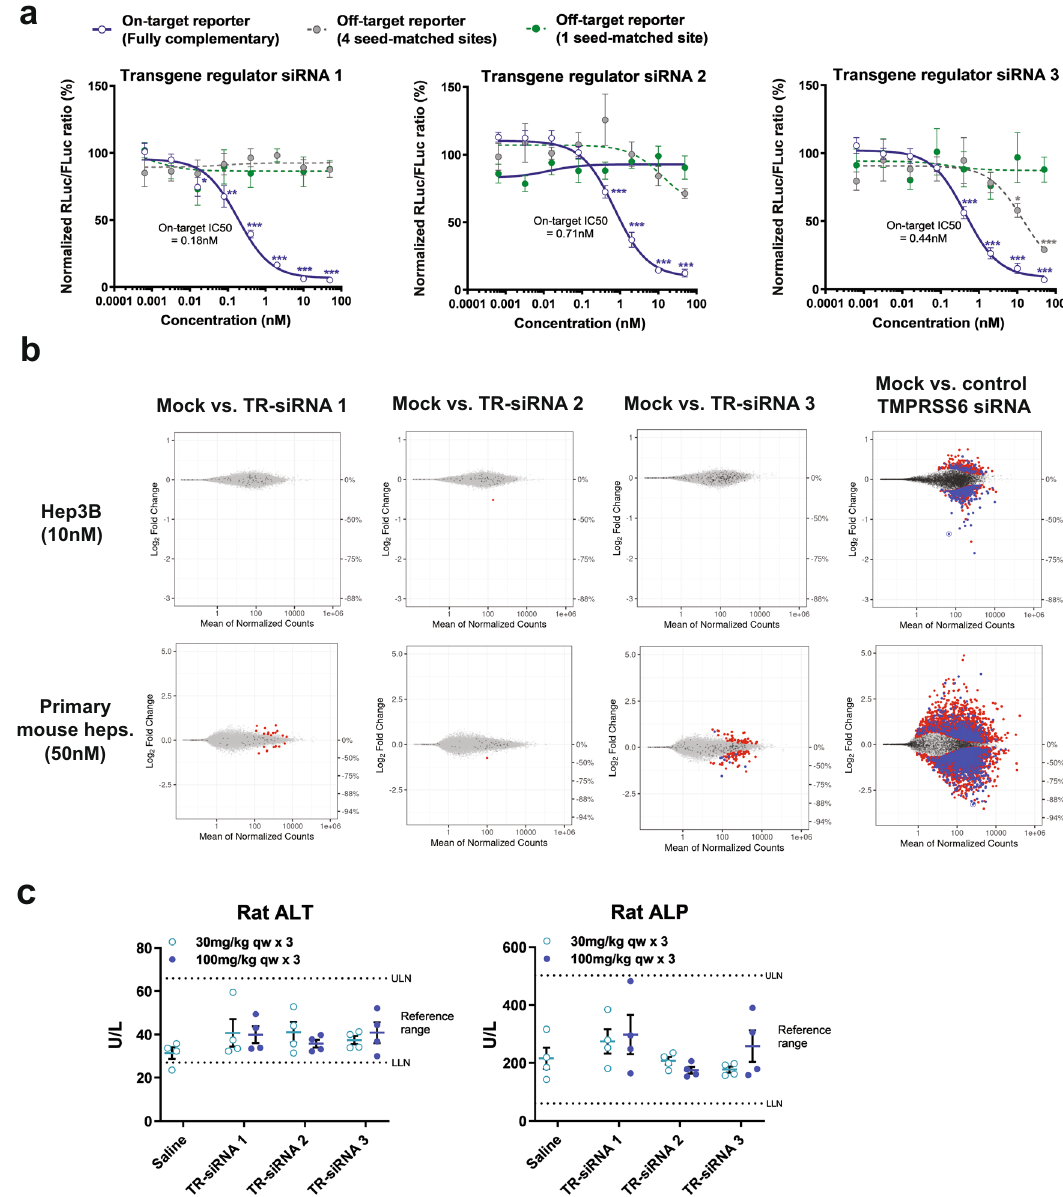
Fig. 4 | In vitro characterization of on- and off-target activity of transgene regulatorsiRNAsequences.a On-targetsilencingef fi cacy(solidblueline)ofthree leadtransgeneregulatorsiRNA(TR-siRNA)sequencesasassayedbyco-transfection ofseriallytitrateddosesofsiRNAwithdualluciferasesensorscontainingaperfectly matched binding site in the 3 ’ UTR of Renilla luciferase (RLuc). Seed-mediated off- target repression was similarly assessed by dose-response activity of siRNA in the presence of luciferase reporters bearing either 1 (green dashed line) or 4 tandem (gray dashed line) seed-matched target sites. RLuc/FLuc ratios were normalized to themock-transfectedcontrol(nosiRNA)conditionsetat100%andplottedasmean ±s.e.m. Data were analyzed using ordinary one-way ANOVA with Bonferroni ’ s test for multiple comparisons ( * p <0.05 ** p <0.01 *** p <0.001). b MA plots depicting differentialgeneexpressionanalysisofRNA-seqdataobtainedfromtransfectionof TR-siRNAs and a Tmprss6 -targeting siRNA control in Hep3B cells (top; 10nM dose harvestedat24h)andprimarymousehepatocytes(bottom;50nMdoseharvested at 48h) ( n =4 biological replicates per condition). Dots represent individual